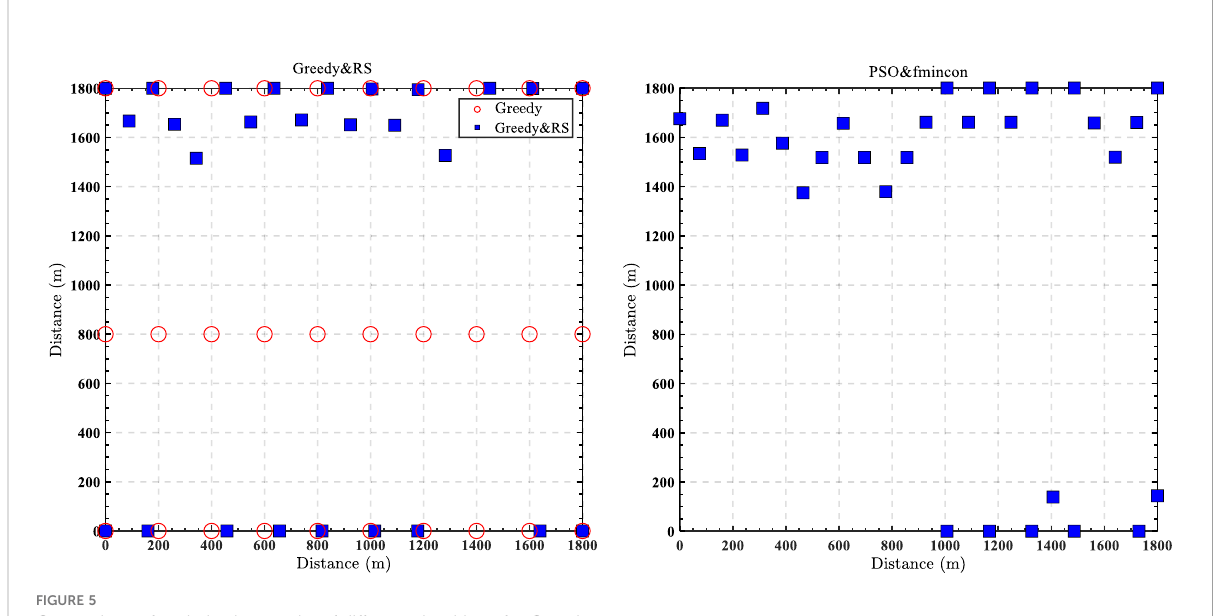
FIGURE 5 Comparison of optimization results of different algorithms for Case 1.